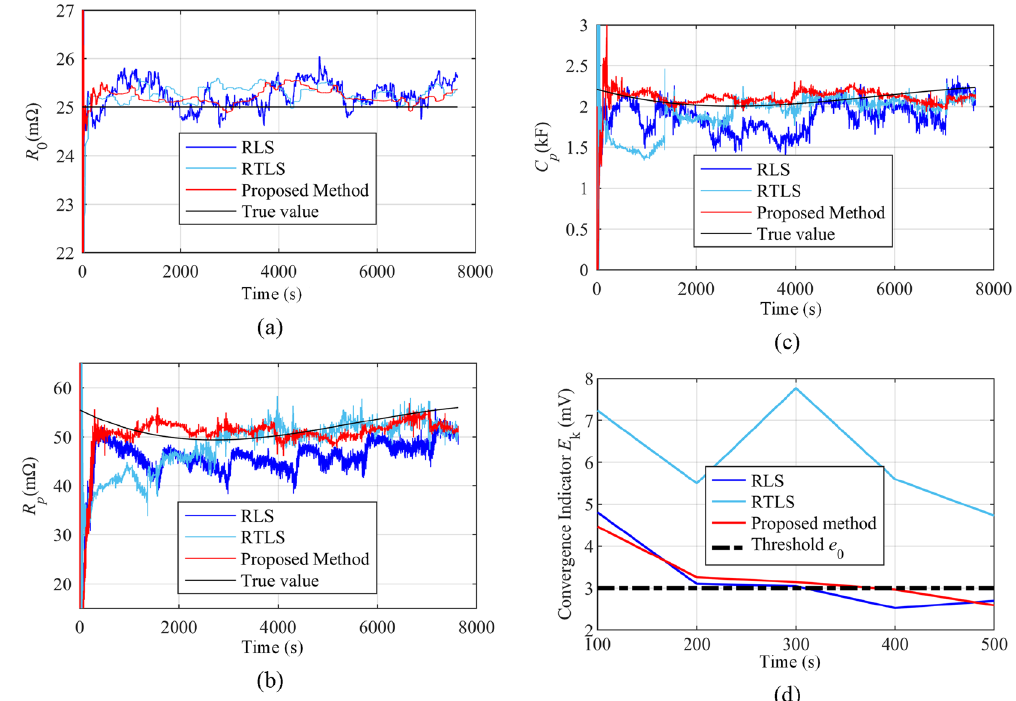
Table 1 Average MSDs of different methods